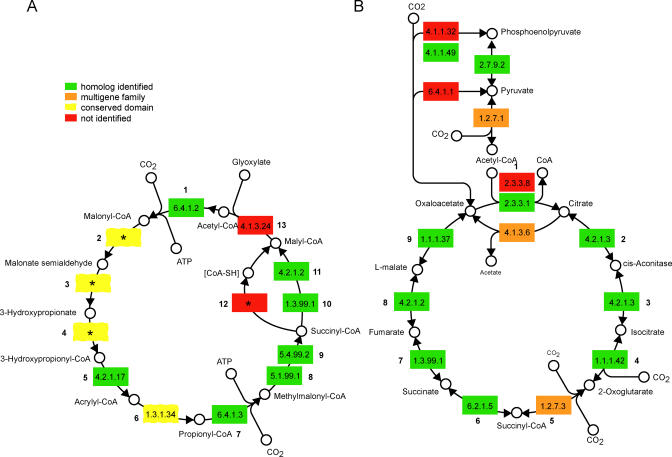
Autotrophic Carbon Assimilation Pathway Components Identified in
C. symbiosum (A) 3-Hydroxypropionate Cycle
Each step is mediated by the following enzymes: (1) acetyl-CoA carboxylase, (2–3) malonyl-CoA reductase, (4–6) propionyl-CoA synthase, (7) propionyl-CoA carboxylase, (8) methylmalonyl-CoA epimerase, (9) methylmalonyl-CoA mutase, (10) succinate dehydrogenase, (11) fumarase, (12) succinyl-CoA/malate CoA transferase, and (13) malyl-CoA lyase (B) TCA cycle. Each step is mediated by the following enzymes: (1) citrate synthase, (2–3) aconitase, (4) isocitrate dehydrogenase, (5) 2-oxoacid ferredoxin oxidoreductase or 2-oxoglutarate dehydrogenase, (6) succinyl-CoA synthase, (7) succinate dehydrogenase, (8) fumarase, and (9) malate dehydrogenase. In the reductive direction, the steps are reversed and citrate synthase is replaced by citrate lyase in (1). Diagrams are based on KEGG pathway maps and include enzyme classification numbers (EC) for each step in boxes when available. Box color indicates the identification status of genes encoding a particular step. See
Tables 1 and
2 for more information.